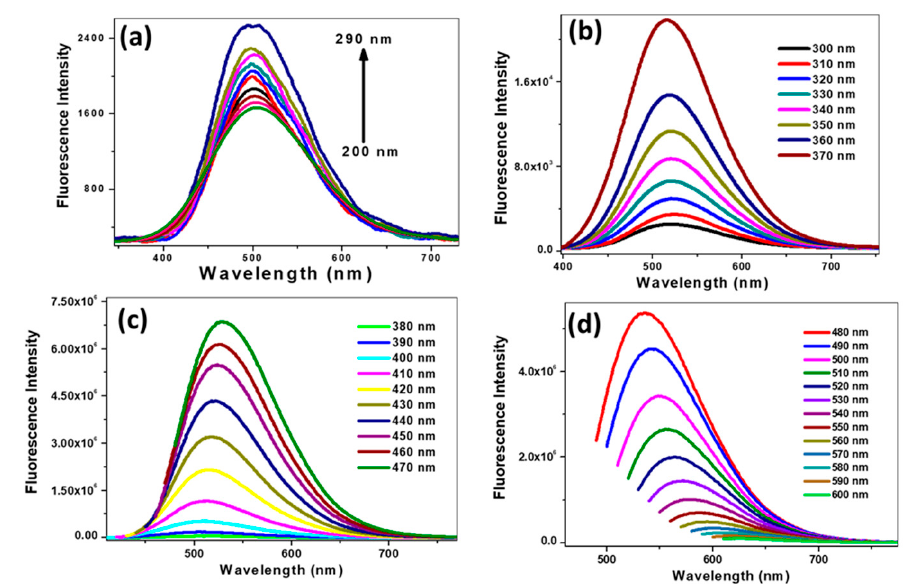
Figure 2. Emission spectra of Avocado CDs with different excitation wavelengths: ( a ) from 200 to 290 nm, ( b ) from 300 to 370 nm, ( c ) from 380 to 470 nm, and ( d ) from 480 to 600 nm ( λ em: 529 nm; λ ex: 470 nm).